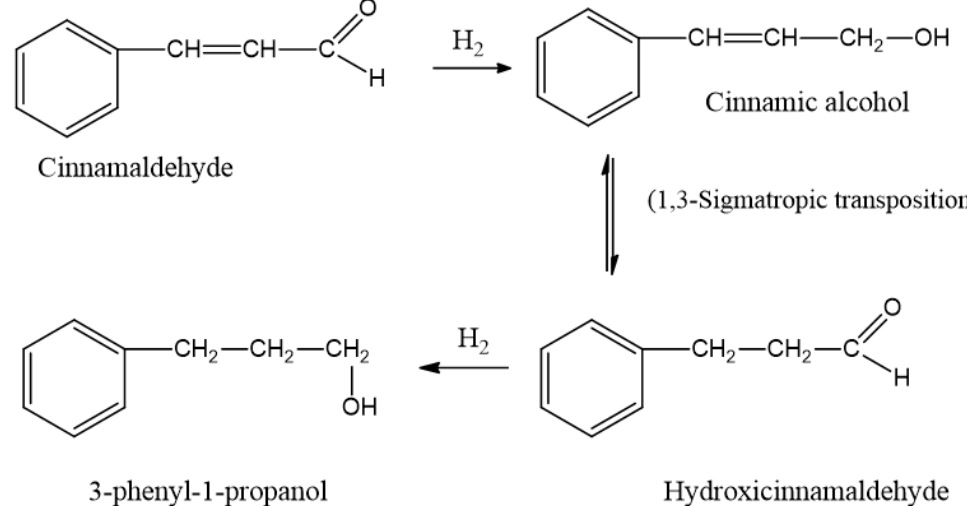
Figure 5. Hydrogenation reaction of cinnamaldehyde.